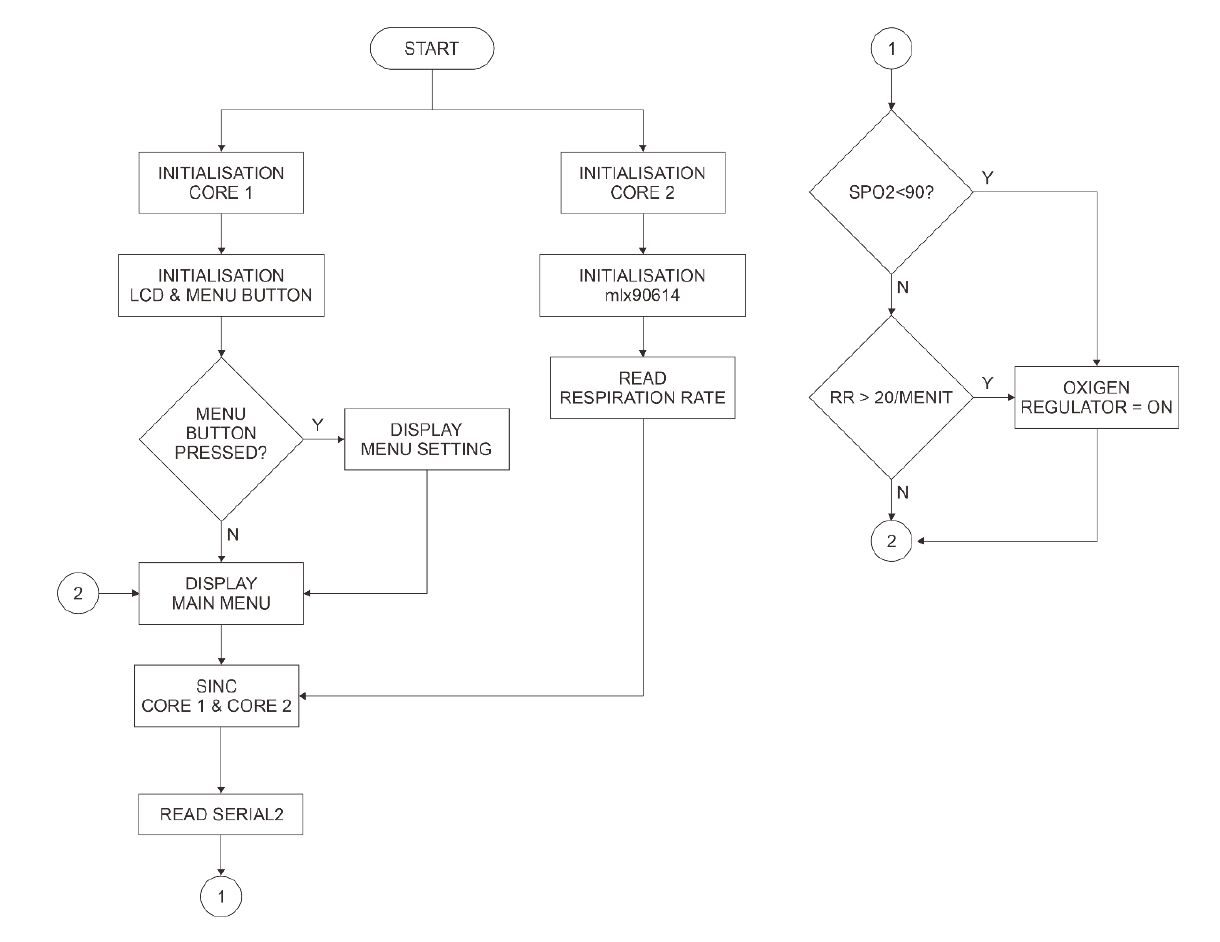
Figure 9 . Flowchart of setting rotation of motor stepper and oxygen output.